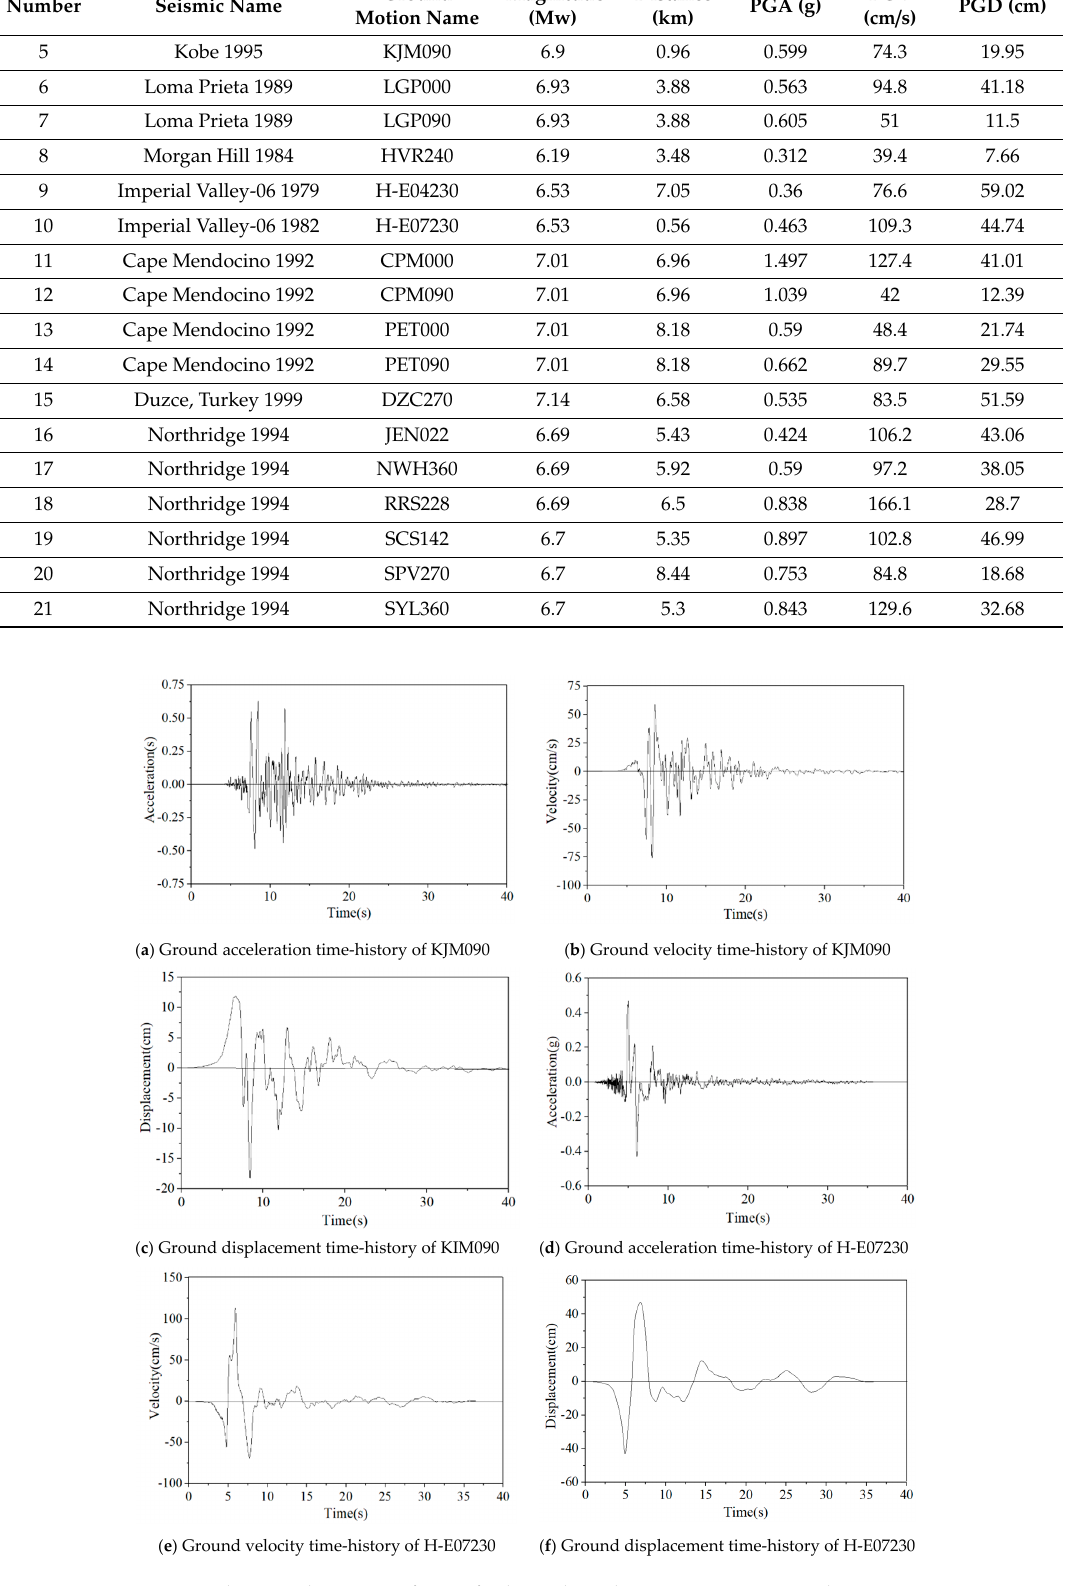
Figure 9. The time-histories of near-fault earthquake waves KJM090 and H-E07230.